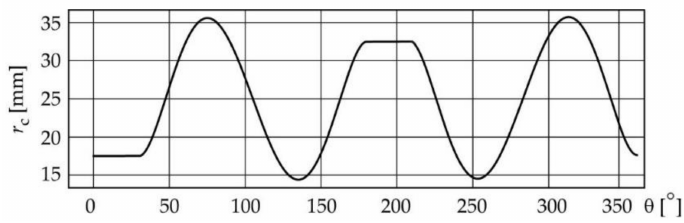
Figure 7. Curvature radii r c of the cam profile with ε = 0 and β =